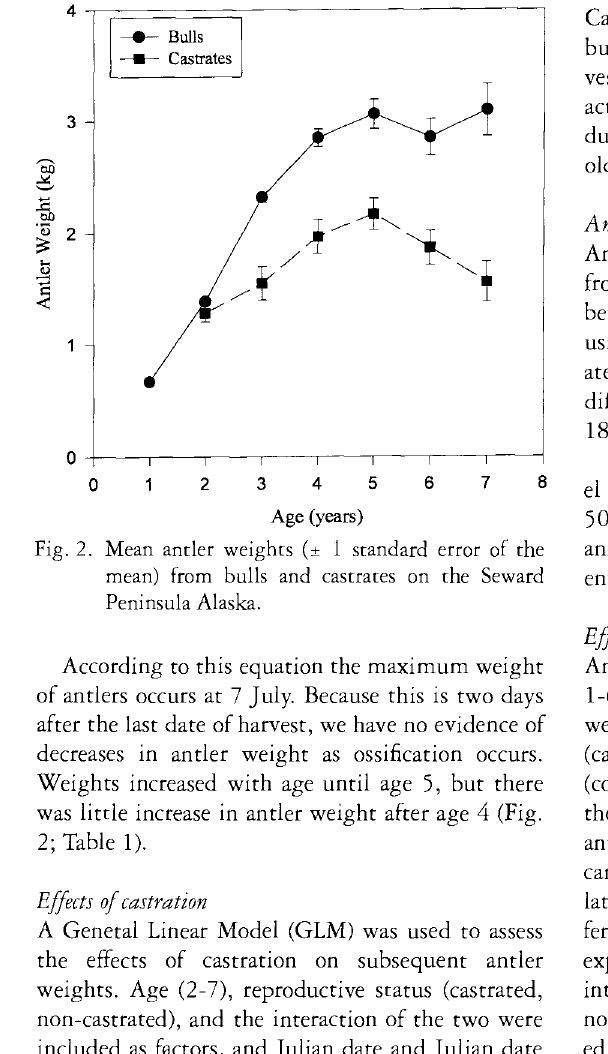
Table 1. Mean weight (kg) of antlers from reindeer males age 1-7 years. All weights adjusted to mean date of harvest (13 June). L.C.L. and U.C.L. are lower 95% confidence limit and upper 95% confidence limit of the mean